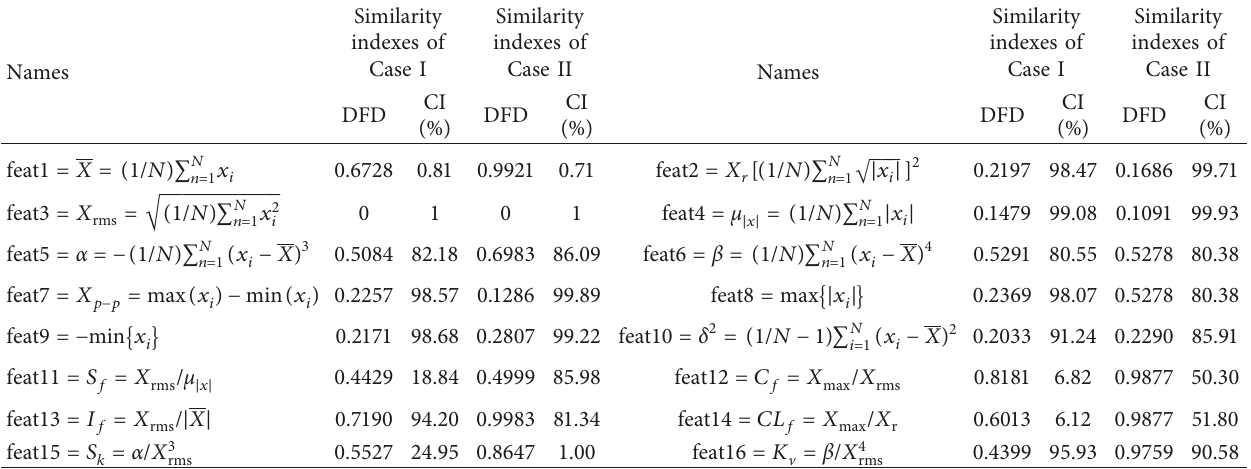
Table 2: The time domain features and their similarity indexes of Case I and Case II based on